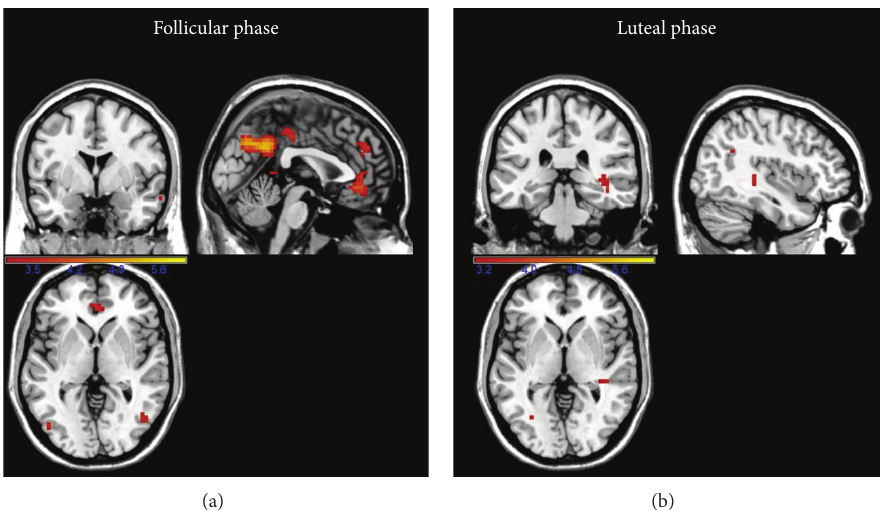
Figure 1: Cerebral activations of female participants, during viewing of appetitive cigarette images (relative to neutral images) and during the follicular and luteal menstrual cycle